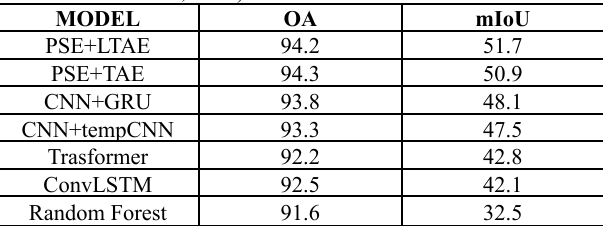
Table 1. The evaluation of the compared models ( Sainte-Fare